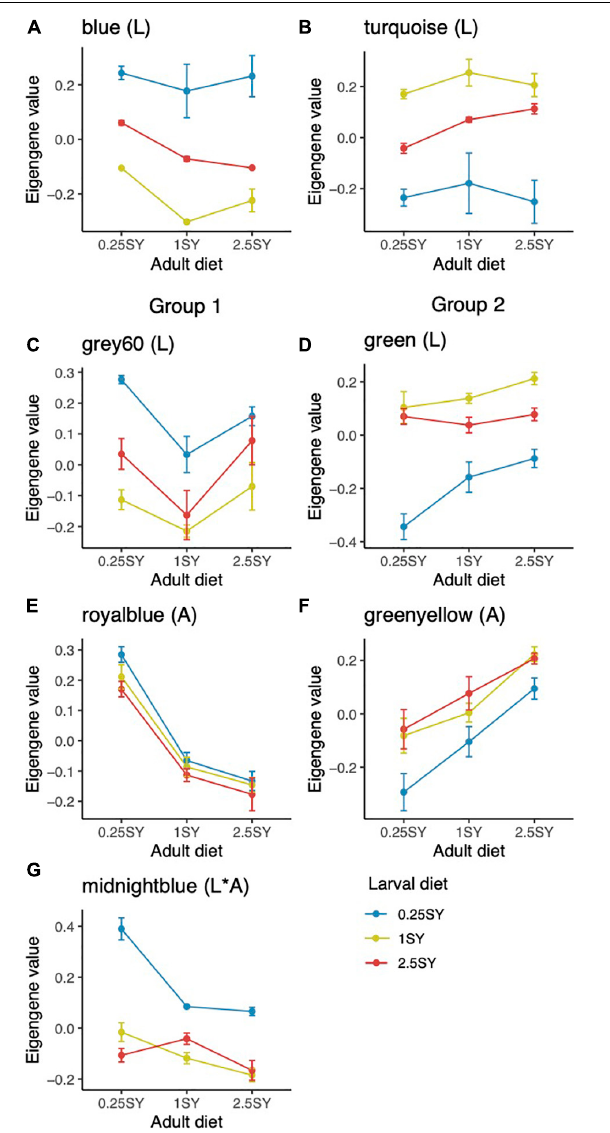
FIGURE 4 | Module eigengene (expression) values across larval (colors) and adult ( x -axis) diets. Module eigengenes of blue (A) and turquoise (B) female modules. Both modules are significantly affected by larval diet. Module eigengenes of gray60 (C) and green (D) male modules. The eigengene values of both modules are significantly affected by larval diet. Module eigengenes of royal blue (E) and green yellow (F) male modules. The eigengene values of both modules are significantly affected by adult diet. (G) Module eigengenes of the midnight blue module. Expression of the midnight blue module is significantly affected by the interaction between larval and adult diet. Male modules can be divided into two groups based on their expression correlation: Group 1 (C,E,G) and Group 2 (D,F) . Within a group eigengene expression is highly correlated, but across groups, eigengene expressions are negatively correlated. All error bars are 95% C.I’s.